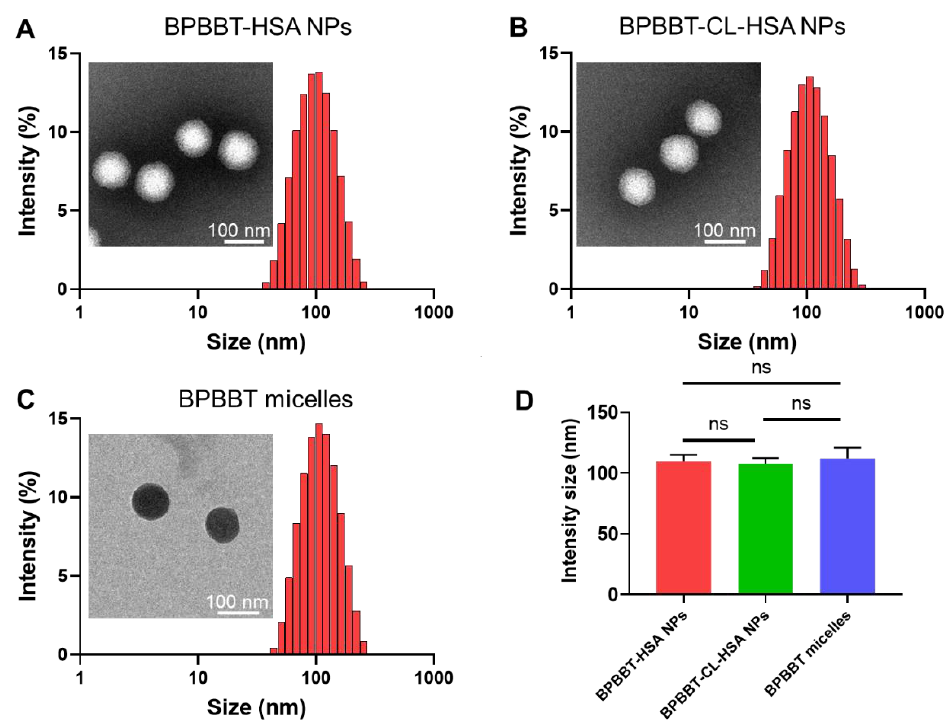
Figure 1. Characterization of different types of BPBBT nanoparticles. ( A – C ) Size distribution and TEM of BPBBT-HSA NPs ( A ), BPBBT-CL-HSA NPs ( B ) and BPBBT micelles ( C ), respectively. The samples of BPBBT-HSA NPs and BPBBT-CL-HSA NPs were negatively stained with 2% phospho- tungstic acid before the TEM. ( D ) The average particle sizes of different types of BPBBT nanoparti- cles. Data are presented as mean ± SD ( n = 3). ns, no significance by one-way ANOVA with a Dun- nett’s post hoc test. Table 1. Characterization of different types of BPBBT NPs a .